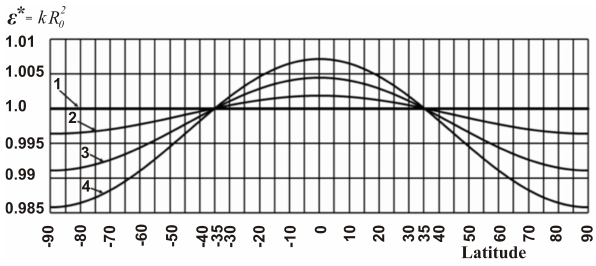
Fig. 5. The dependence of the Gaussian curvature normalized to the sphere curvature ε ∗ = κ R 2 over latitude for different ellipticity 0 values: 1 for ε 0 =0 – (sphere), 2 for ε =0.00135, 3 for ε =0.00335 – (the Earth), 4 for ε =0.00535. The vertical axis is a normalized